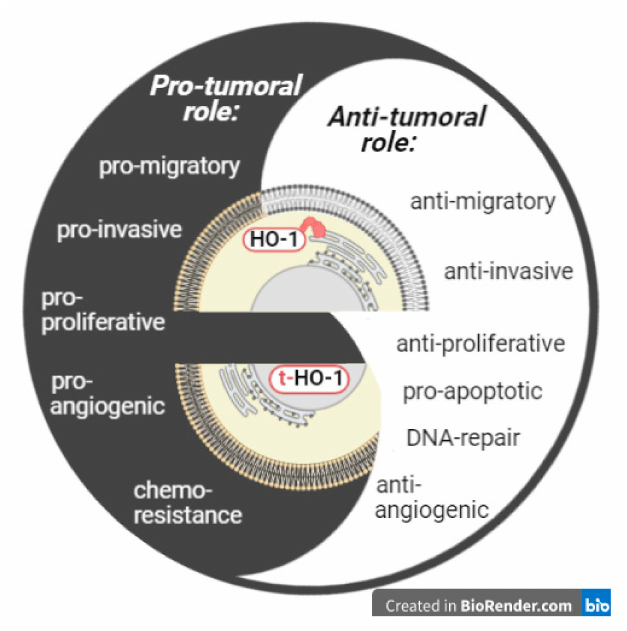
Figure 2. Subcellular compartmentalization of HO-1 conditions its role in malignancies. Full-length HO-1 resides in the sER, is enzymatically active and may play an antitumor or protumor role. Truncated HO-1 resides in the nucleus, lacks enzymatic activity and may play a protumor